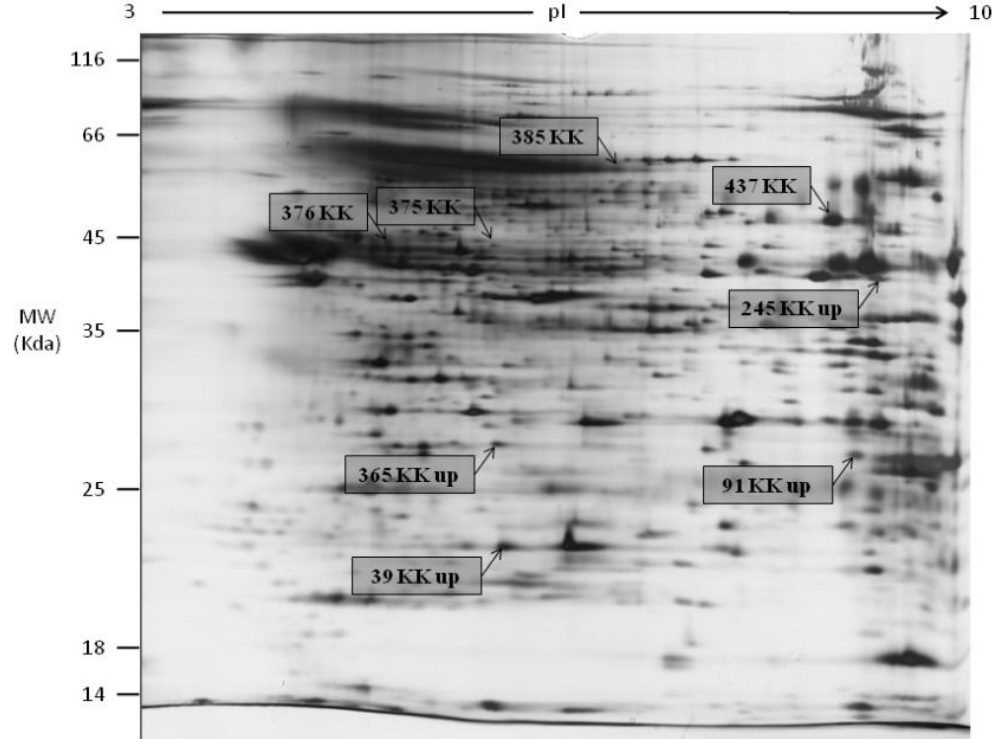
Figure 2. Representative gel showing protein spots with different abundance in Kedah Kelantan